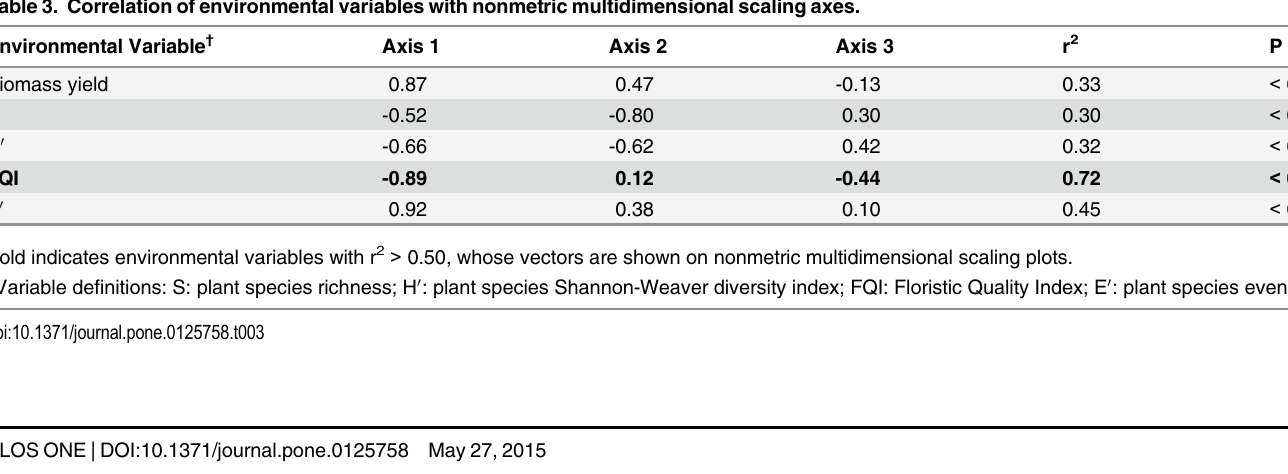
Table 3. Correlation of environmental variables with nonmetric multidimensional scaling axes. Environmental Variable †